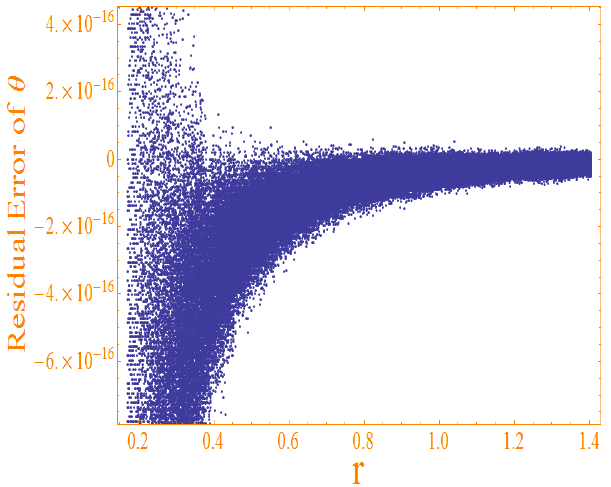
Figure 2. Residual error curves of temperature distribution θ .